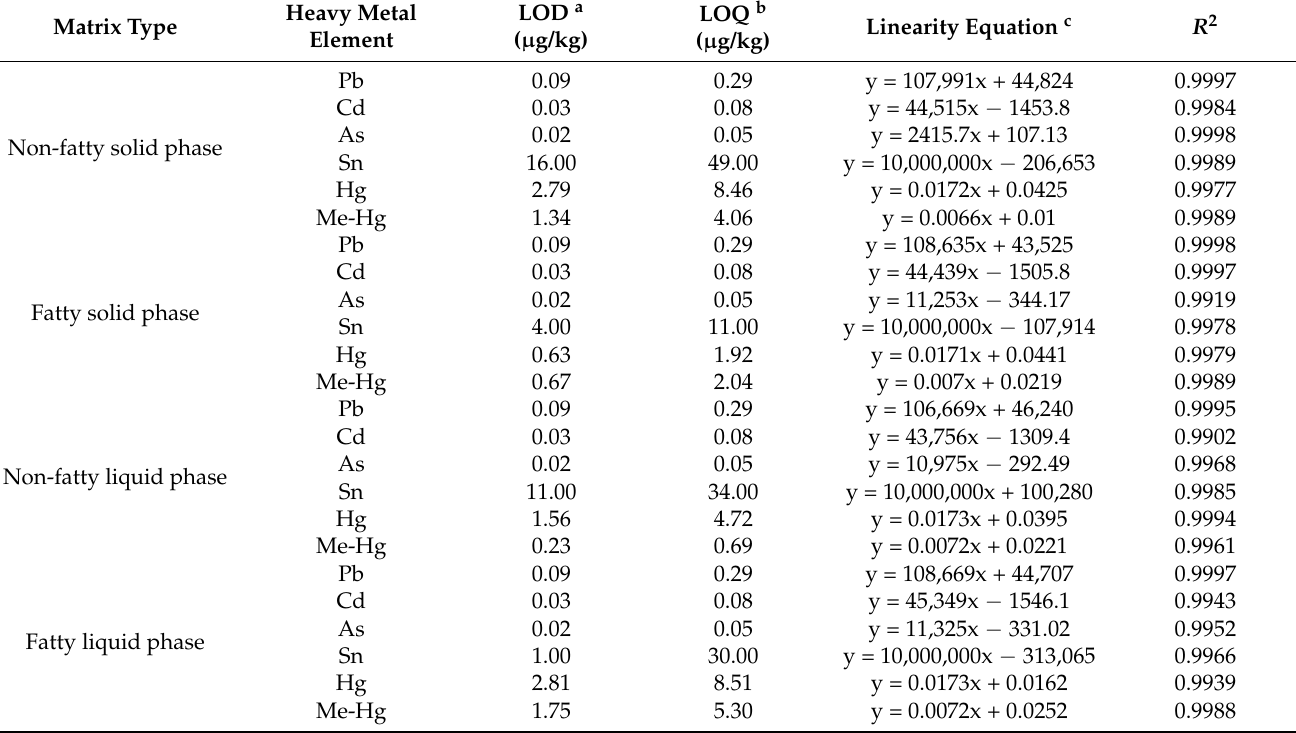
Table 1. The LOD, LOQ, linearity equations, and R 2 of the six heavy